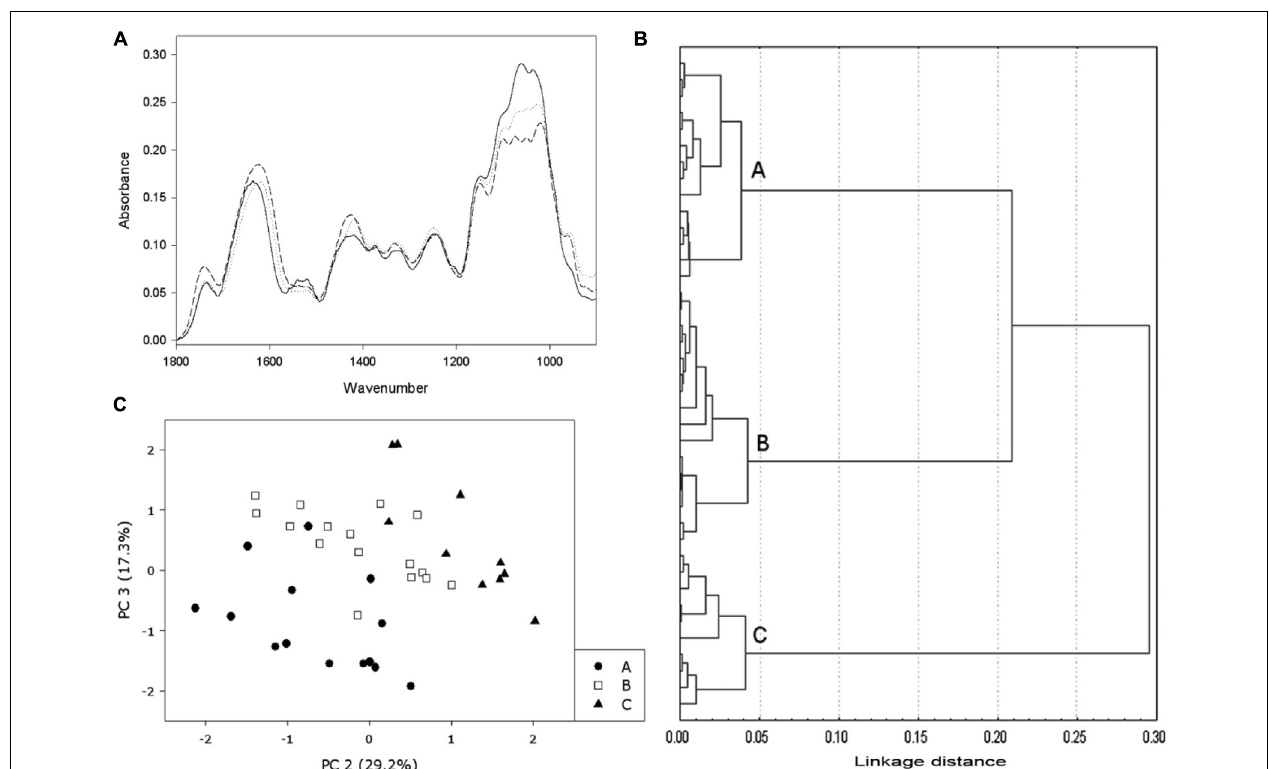
concentrations ranging from 0.5 to 12 μ M; the analysis made three different groups: non-habituated (group A), low level of habituation (group B) and high level of habituation to DCB (group C). (C) Principal Component Analysis (PCA) performed on the same bulk of spectra.The same groups of cluster analysis can be observed. (Data from Alonso-Simón etal.,